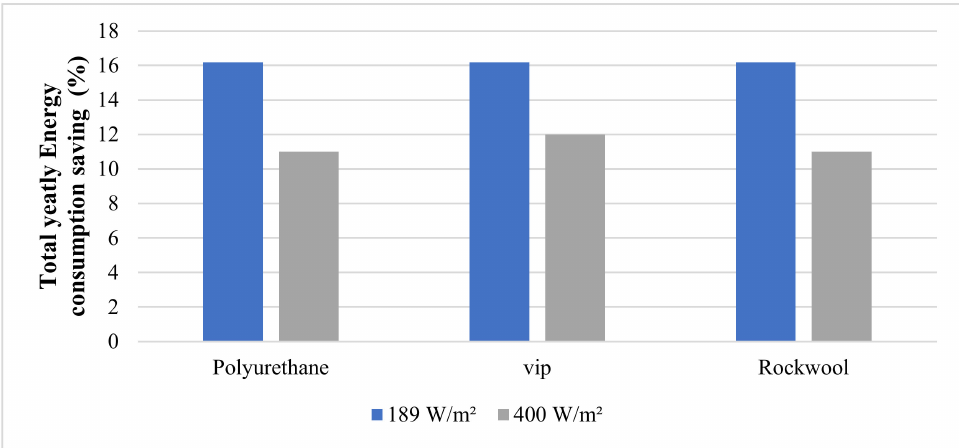
Figure 9. Yearly reduction in the total energy consumption of the building applying different types of window glass integrating three types of window shutters’ insulations for different solar